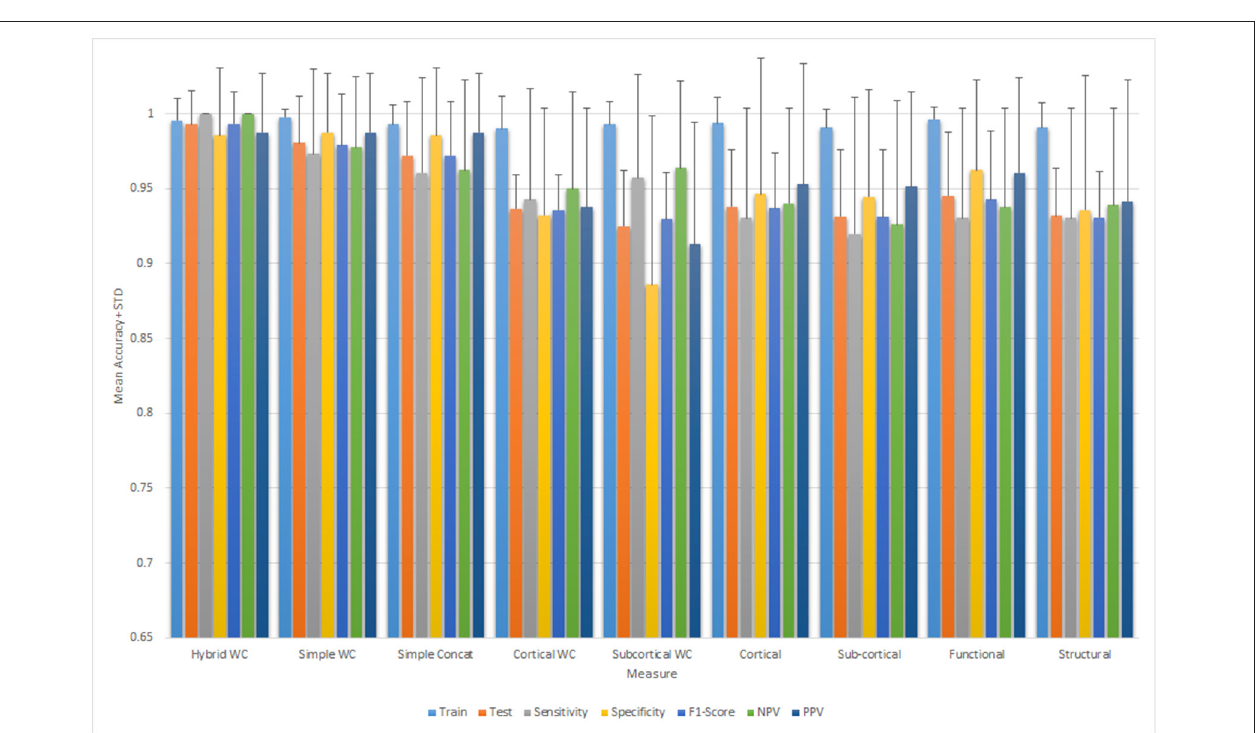
FIGURE 5 | Mean and standard deviation of the classification performance parameters for